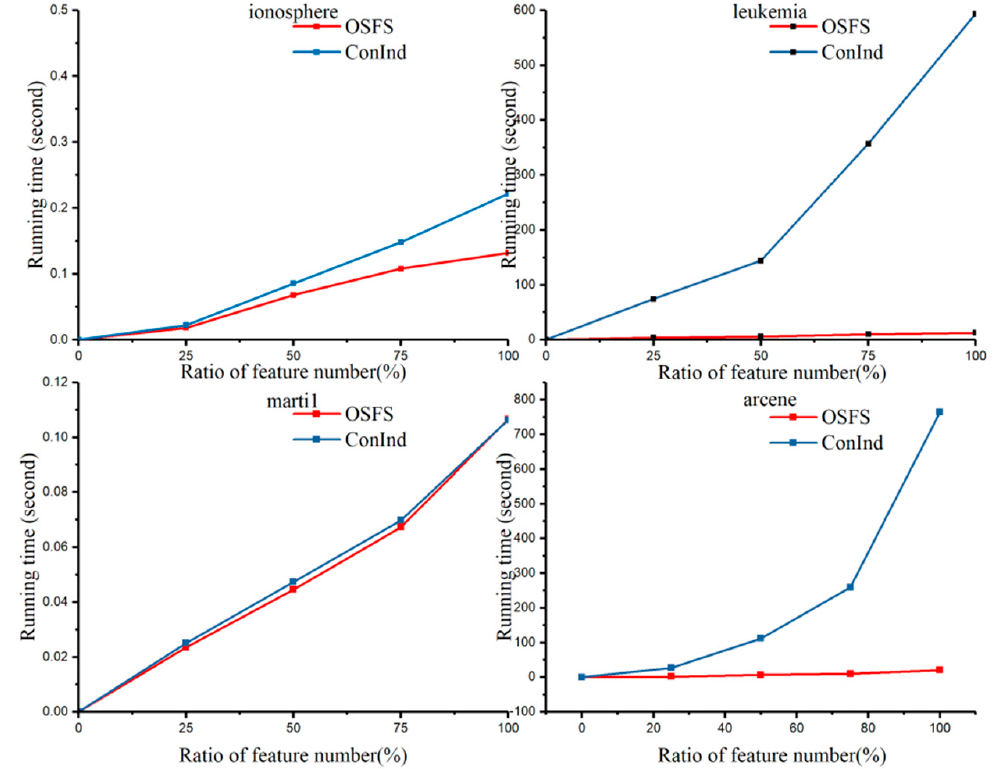
Figure 9. The variation of running time with the increase of ratio feature number with high redundancy and low relevance.